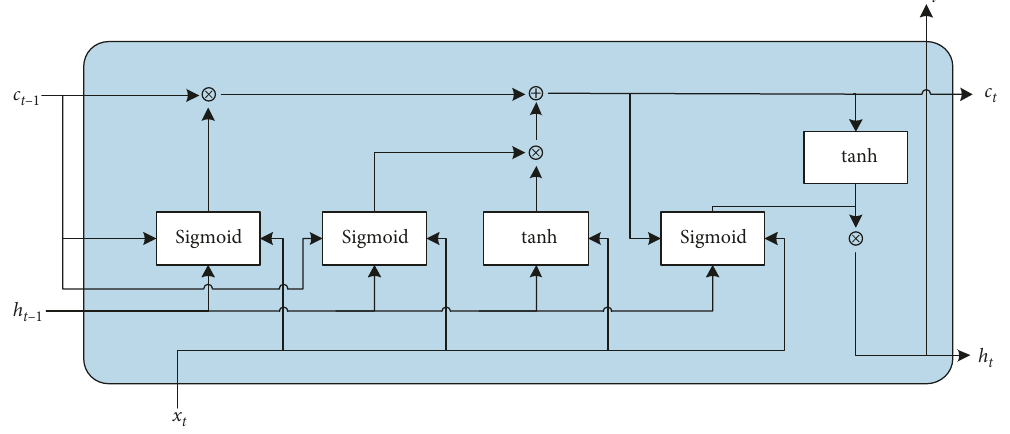
Figure 11: Structure of the memory unit in